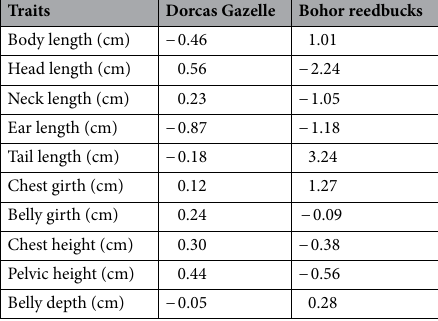
| B j | σ obtained from the full model for Dorcas gazelle and Bohor reedbucks.